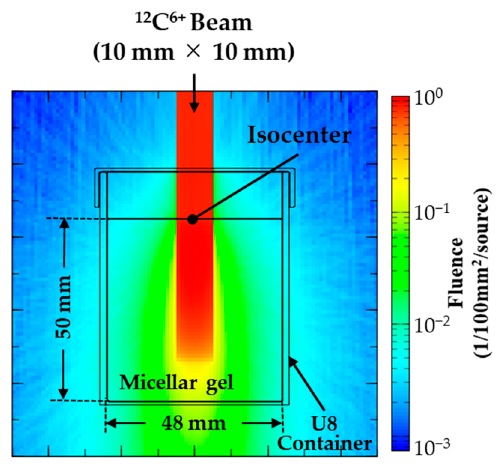
Figure 3. Irradiation of a micellar gel specimen with carbon ion beam under beam condition (A) and the resulting fluence.